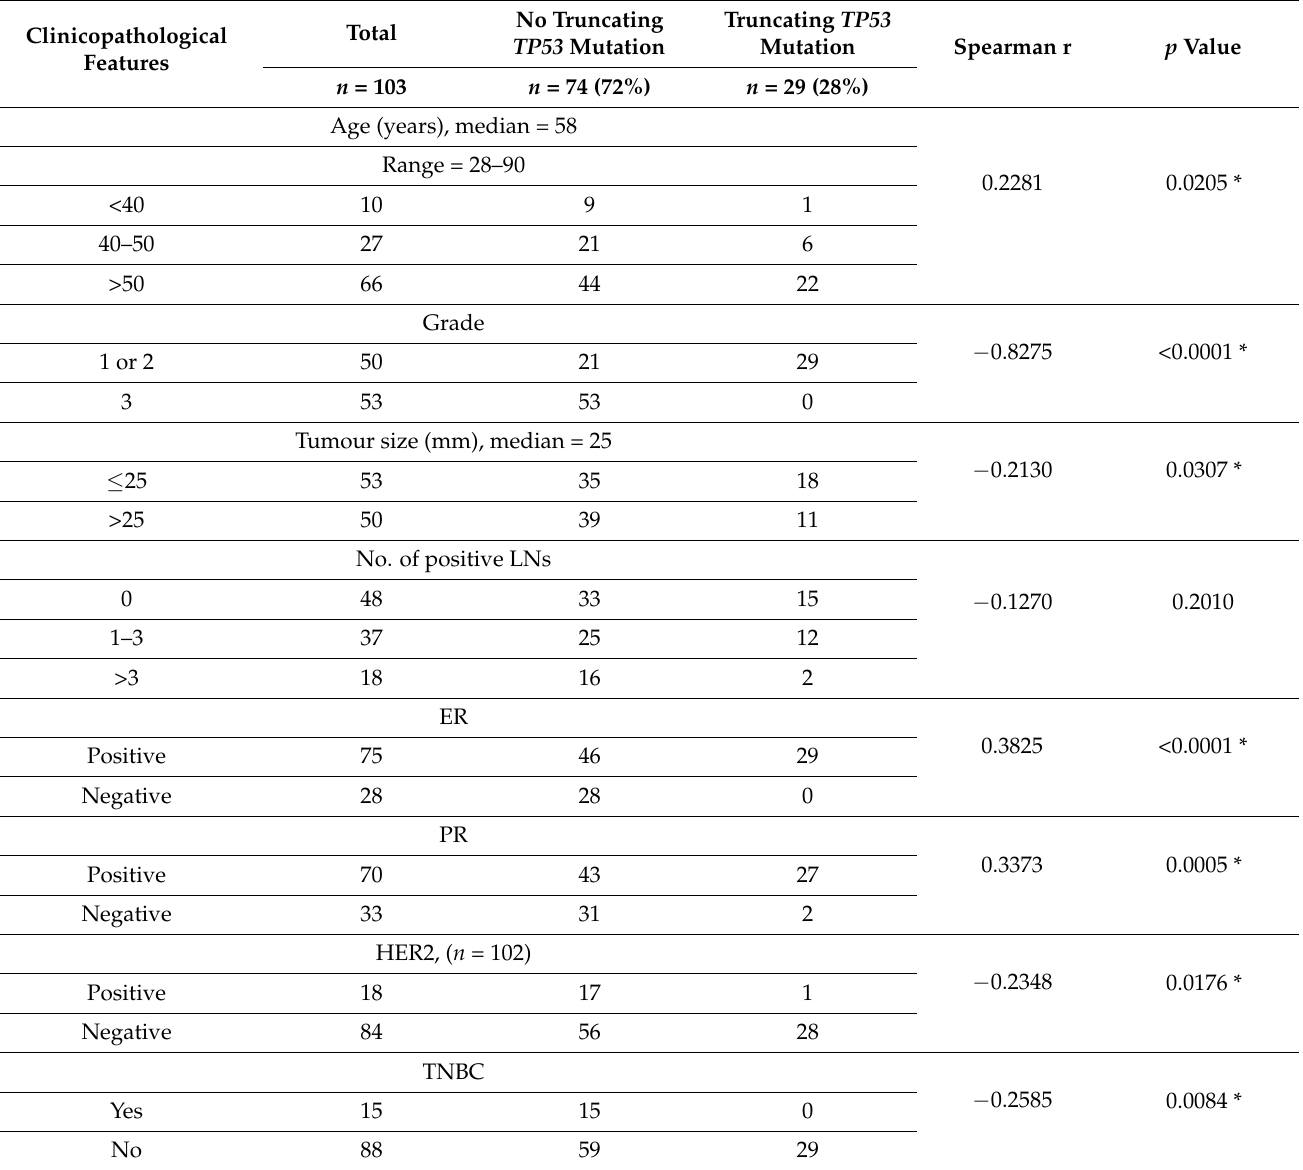
Table 2. Association of truncating TP53 mutations with clinicopathological